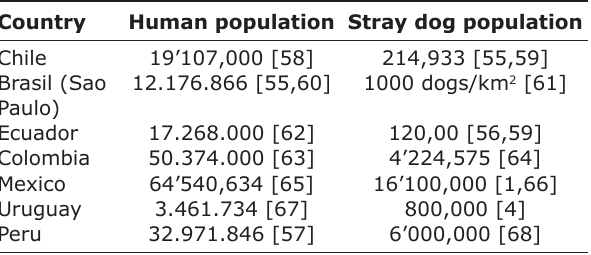
Table-1: The human and stray dog population in in selected countries of Latin America.